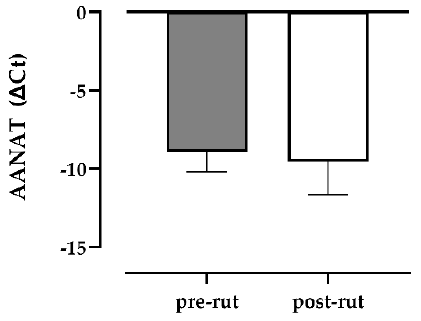
Figure 2. Differences between pre-and post-rut groups for the gene expression of the enzyme AANAT (aralkylamine-N-acetyltransferase).